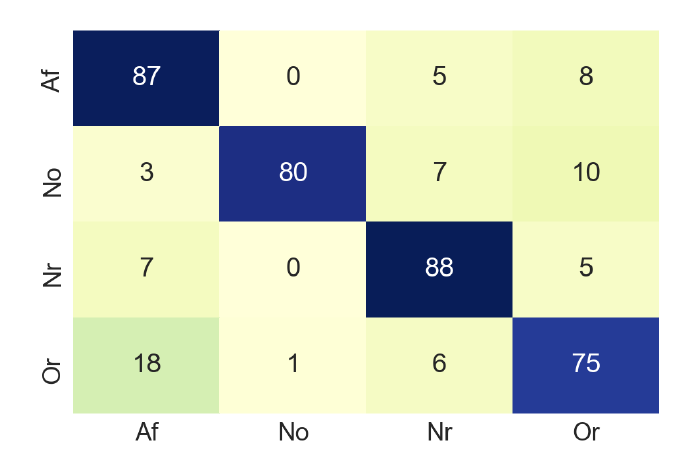
Figure 8. Extraction of the area of interest from the image.